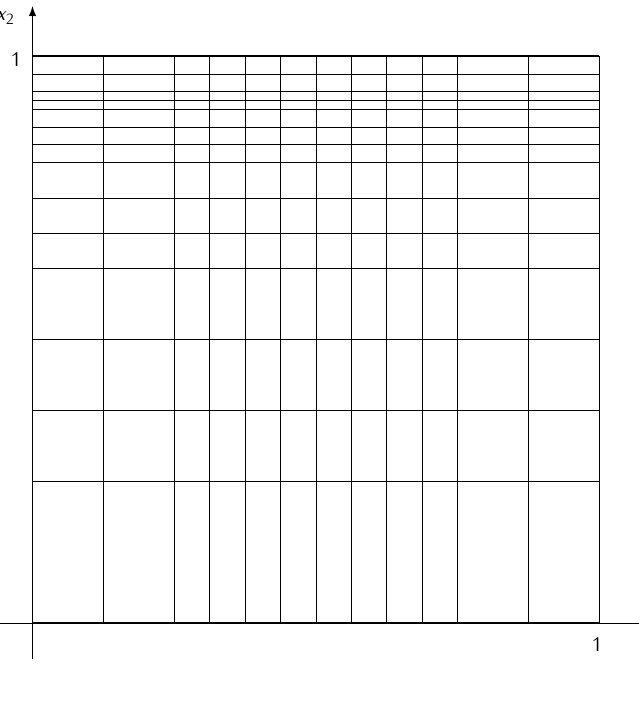
Figure 6. Optimised triangulation